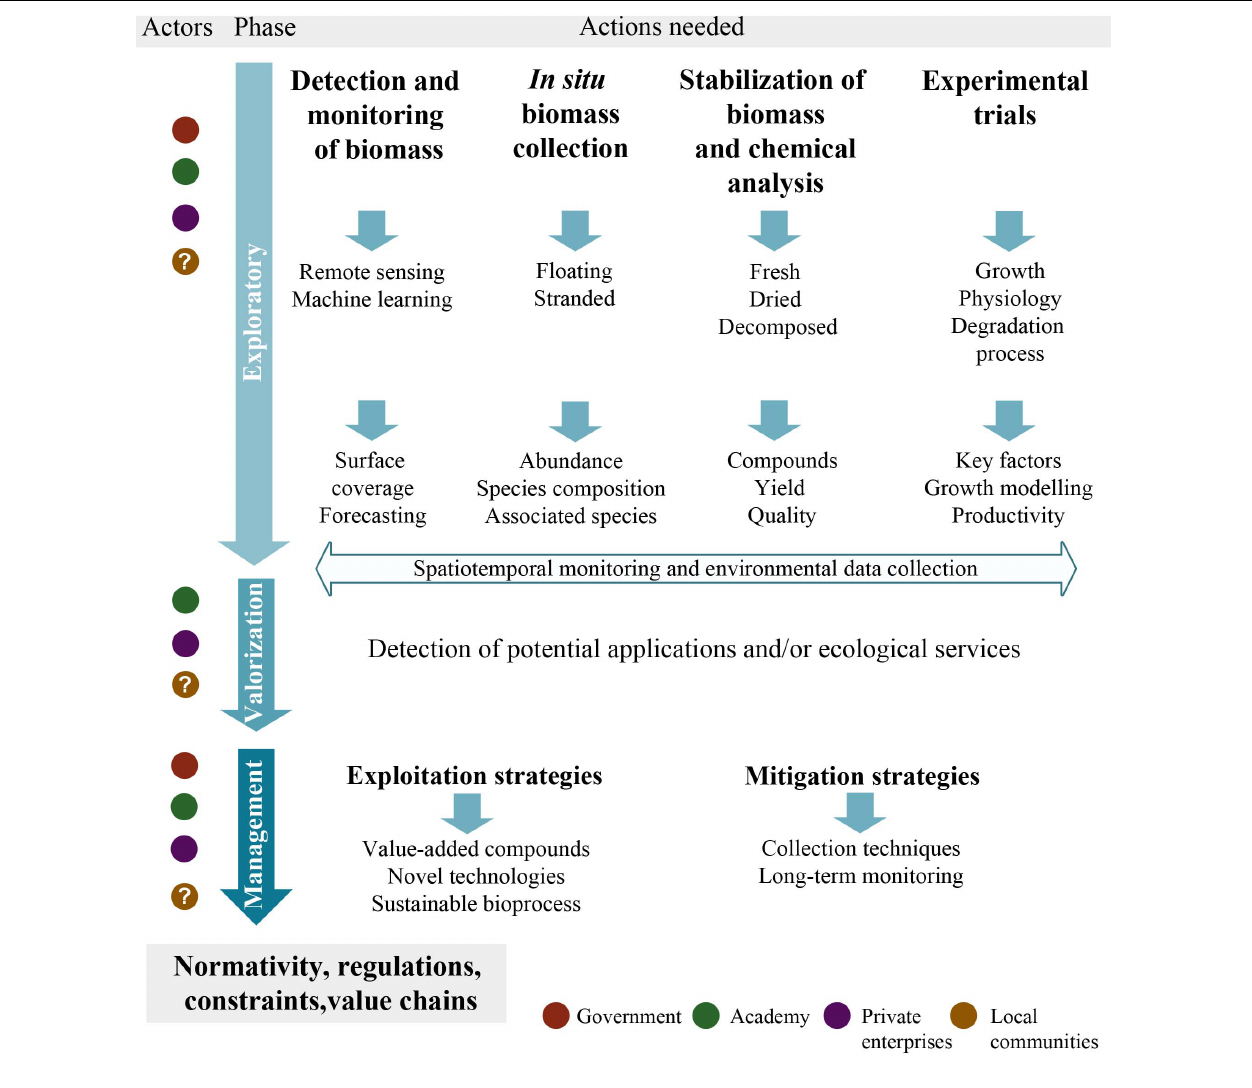
FIGURE 2 | Strategies to address the management of Sargassum events in the region. The actions needed, relevant factors and actors involved are included, from exploratory to management phase. ?: indicates that official information is not available to identify the specific role of local